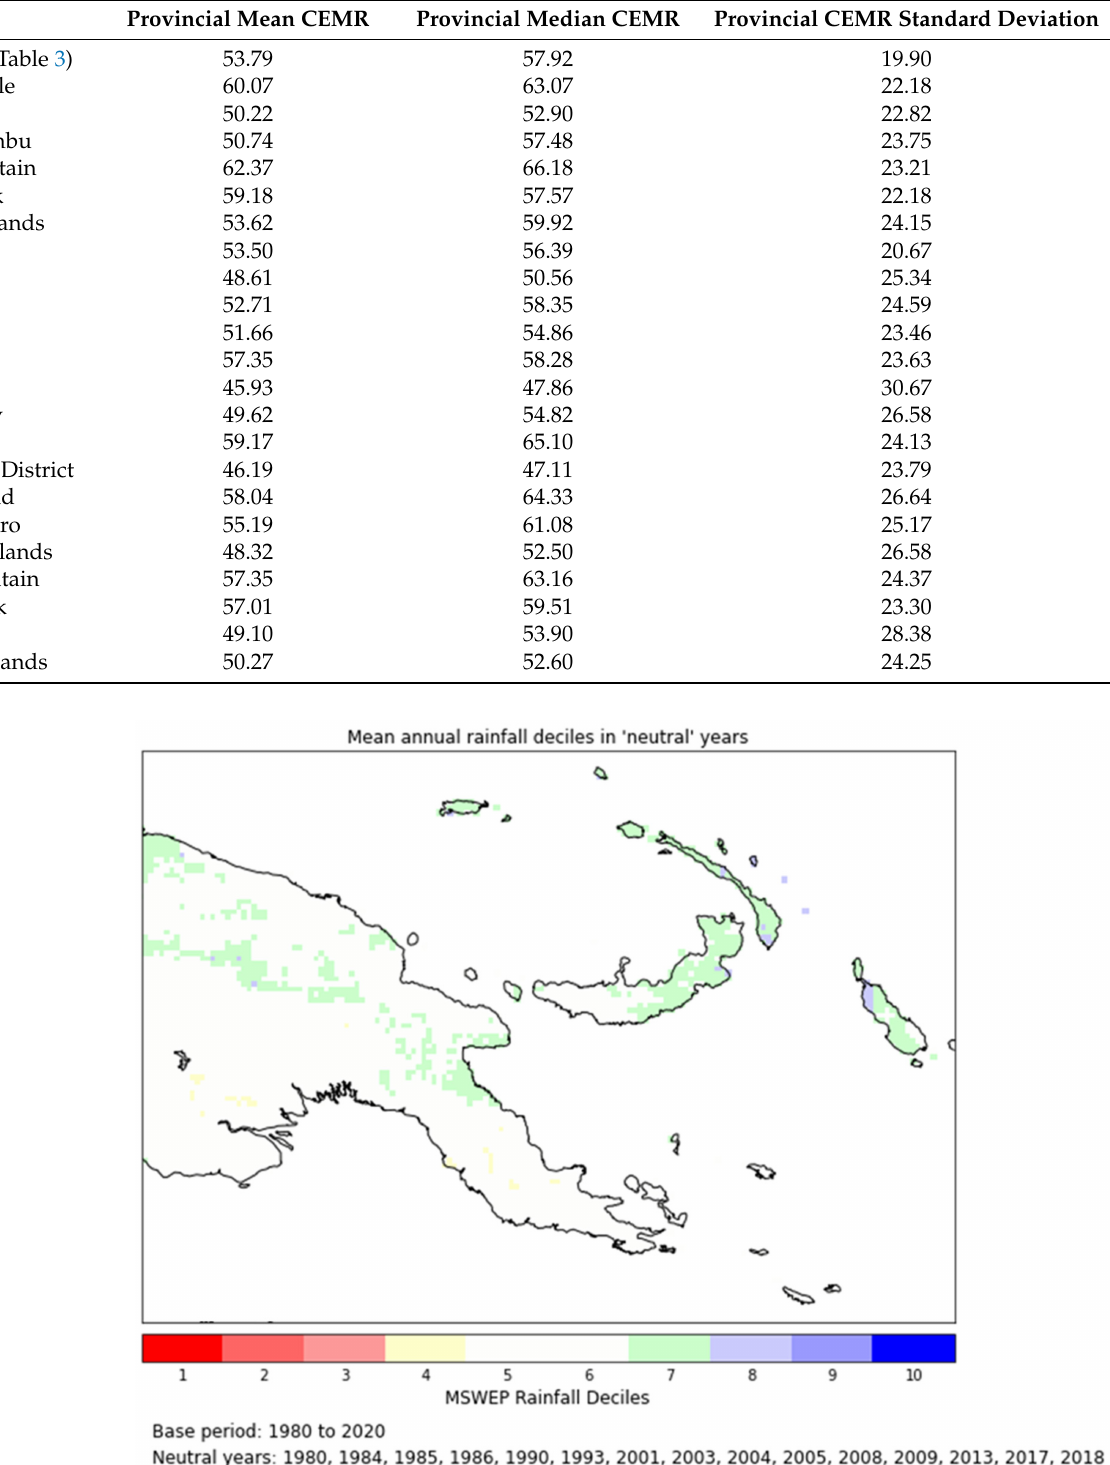
Table A3. Mean, median and standard deviation for provincially averaged CEMR.